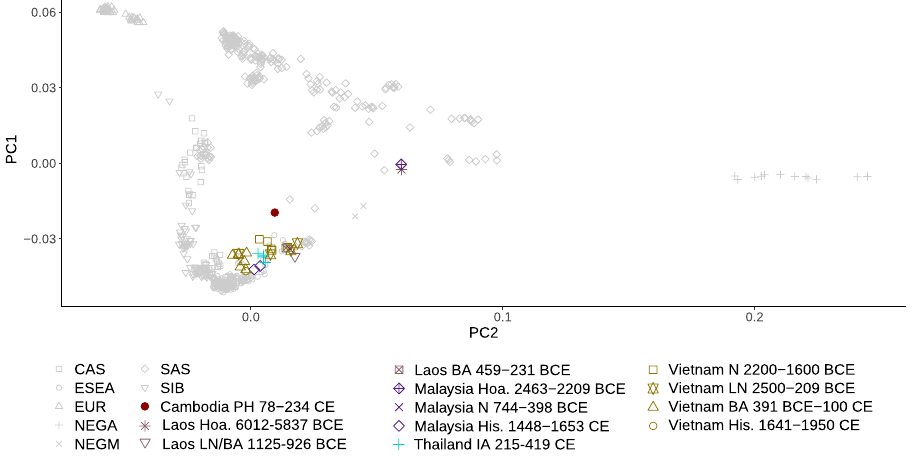
Figure 2. Principal component analysis (PCA). Ancient Southeast Asian individuals were projected on the principal components calculated using present-day Eurasian populations, and the first two components (PC1 and PC2) are shown. Abbreviations for meta-populations are as follows: CAS present-day Central Asians, ESEA present-day East and Southeast Asians, EUR present-day Europeans, NEGA present-day Andamanese Negritos, NEGM present-day Mainland Southeast Asian Negritos, SAS present-day South Asians, SIB present-day Siberians, Hoa. Hoabinhian culture, N Neolithic, LN Late Neolithic, PH Protohistoric period, BA Bronze Age, His. Historical